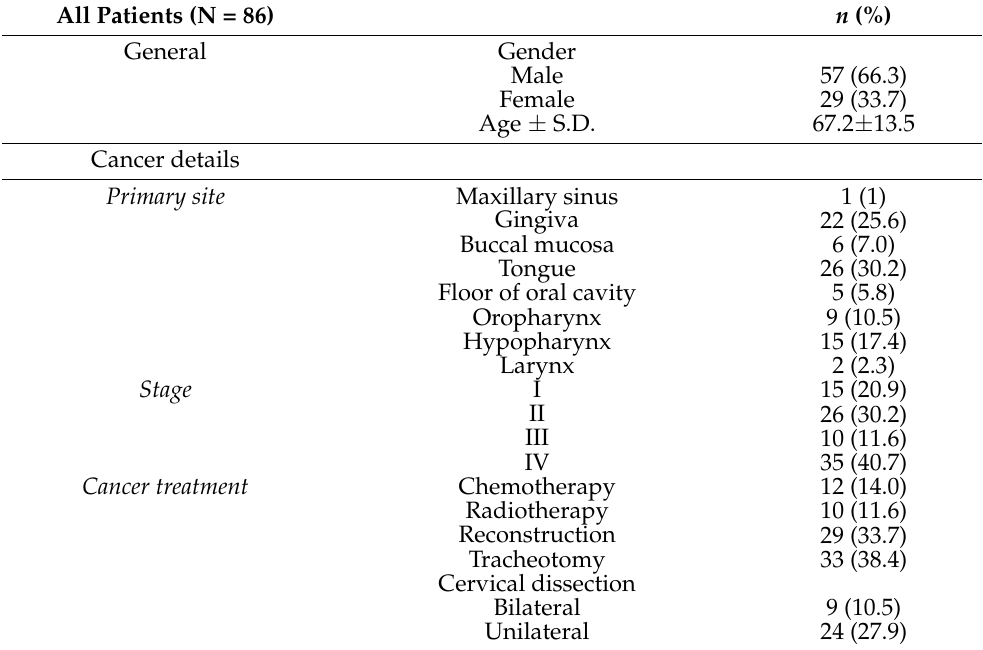
Table 2. Patient